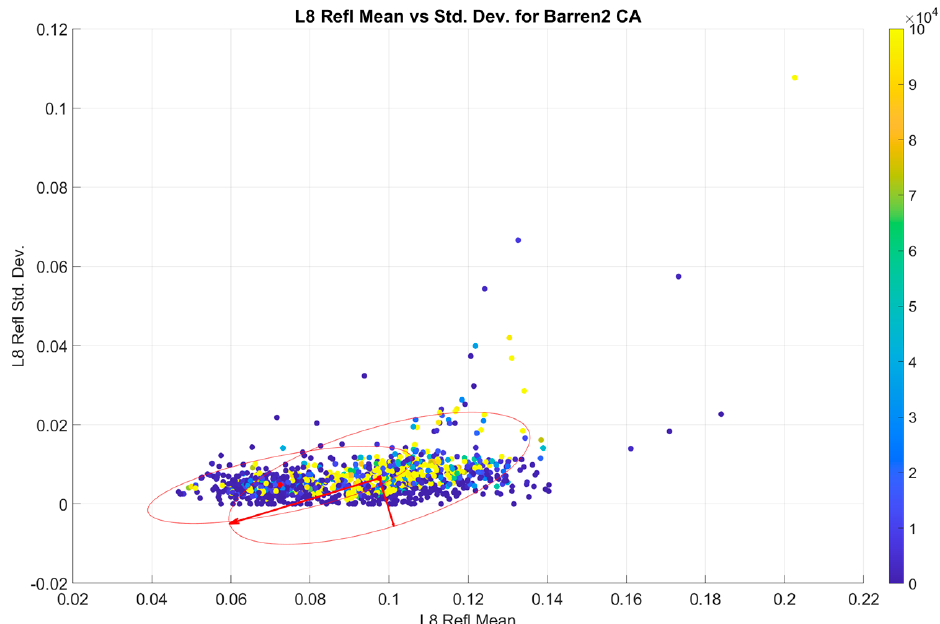
Figure 8. Weighted ellipse filter for Barren2 CA band, with the eigenvectors dictating the shape of the ellipse. Note that in this example, the high pixel counts of the outliers “pull” the slope of the ellipse up. The points are color coded by pixel count, with the scale on the right of the plot. The arrows indicate the eigenvectors that create the boundaries of the ellipse.